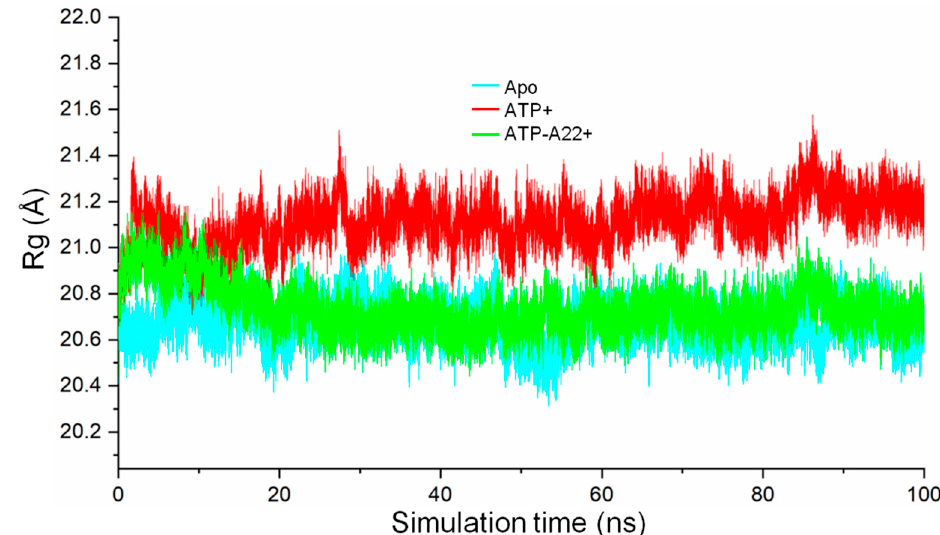
Figure 5. Radius of gyration (Rg) of backbone atoms of chain B in the apo, ATP+, and ATP-A22+ protofilaments. The cyan, red, and green curves represent the radius of gyration of chain B of the apo, ATP+, and ATP-A22+ filaments, respectively.